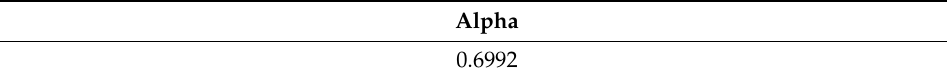
Table 7. Lean Cronbach’s